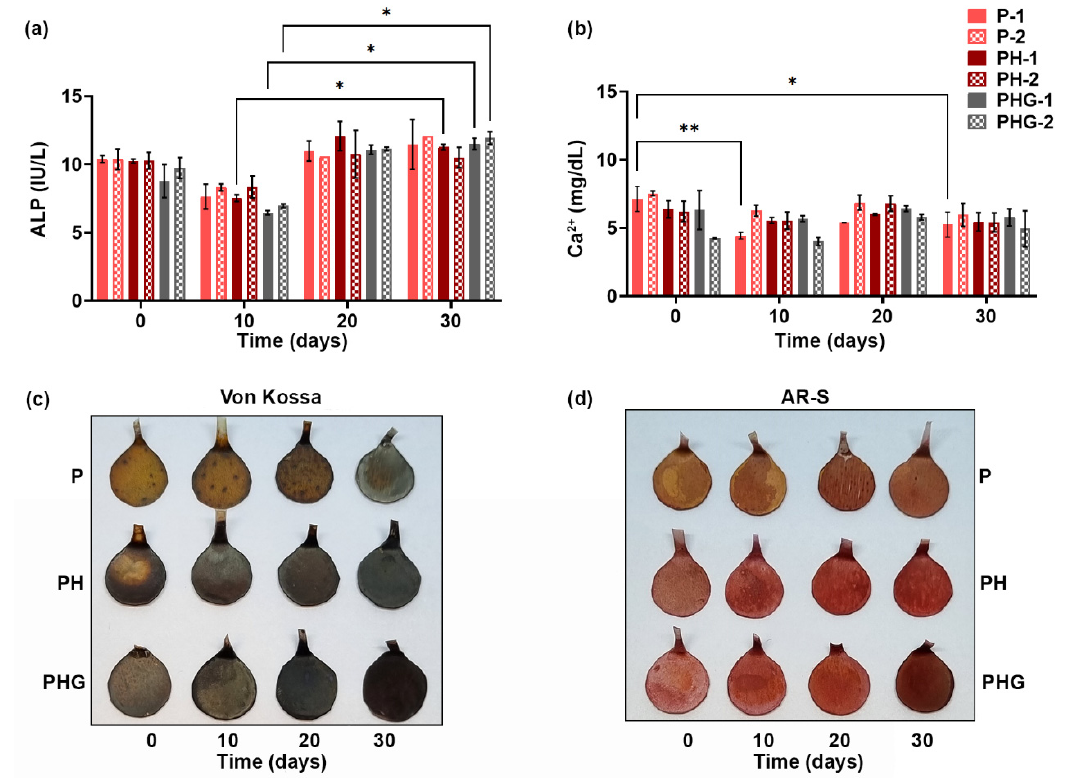
Figure 10. Osteogenic activity of cells cultured on P, PH, PHG membranes: ( a ) Alkaline phosphatase activity and ( b ) extracellular calcium secretion of the osteoblasts up to 30 days. Macrographs showing histochemical stainings: ( c ) von Kossa, and ( d ) Alizarin red S-stained samples. Circular cut membranes are 9.8 mm in diameter; tails are left for ease of handling. Statistical significance; * p ≤ 0.05, ** p ≤ 0.01.